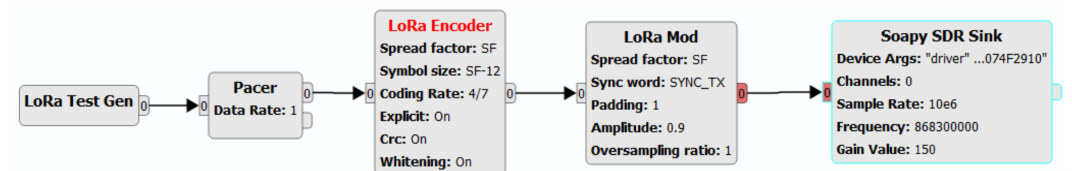
Figure 8. LoRa tra ffi c generator by integrating Software Defined Radio (SDR) technology. The integrated communication mechanism can generate a high volume of data with the help of LoRa packet